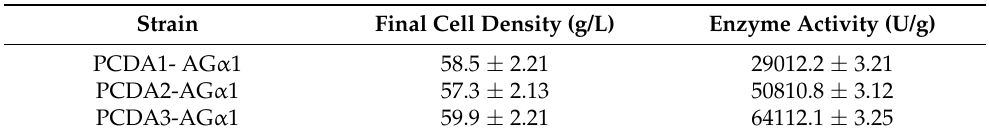
Table 3. Comparations of the enzyme activity of PCDA1- AG α 1, PCDA2-AG α 1, and PCDA3-AG α 1. Strain Final Cell Density (g/L) Enzyme Activity